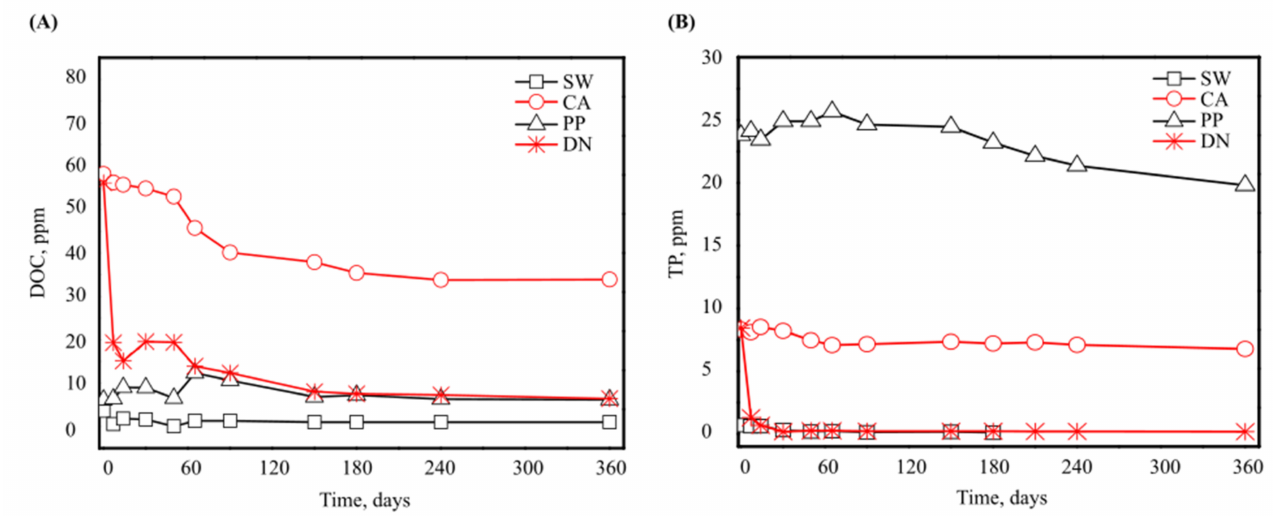
Figure 1. DOC ( A ) and TP ( B ) concentrations of the incubated seawater in the presence and absence of 100 mg/L polyacrylic acid- (CA), polyphosphonate- (PP), and carboxylated dendrimer- (DN) based antiscalants over one year of